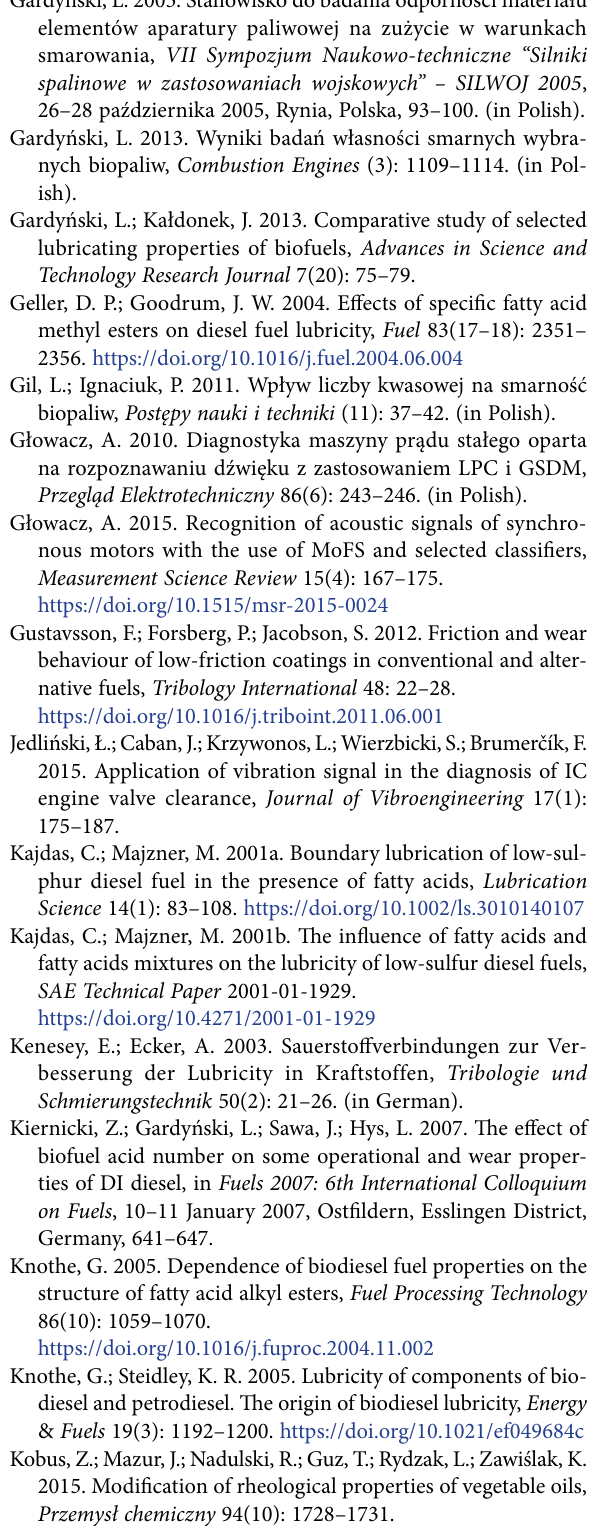
Figlus, T. 2015. The application of a continuous wavelet